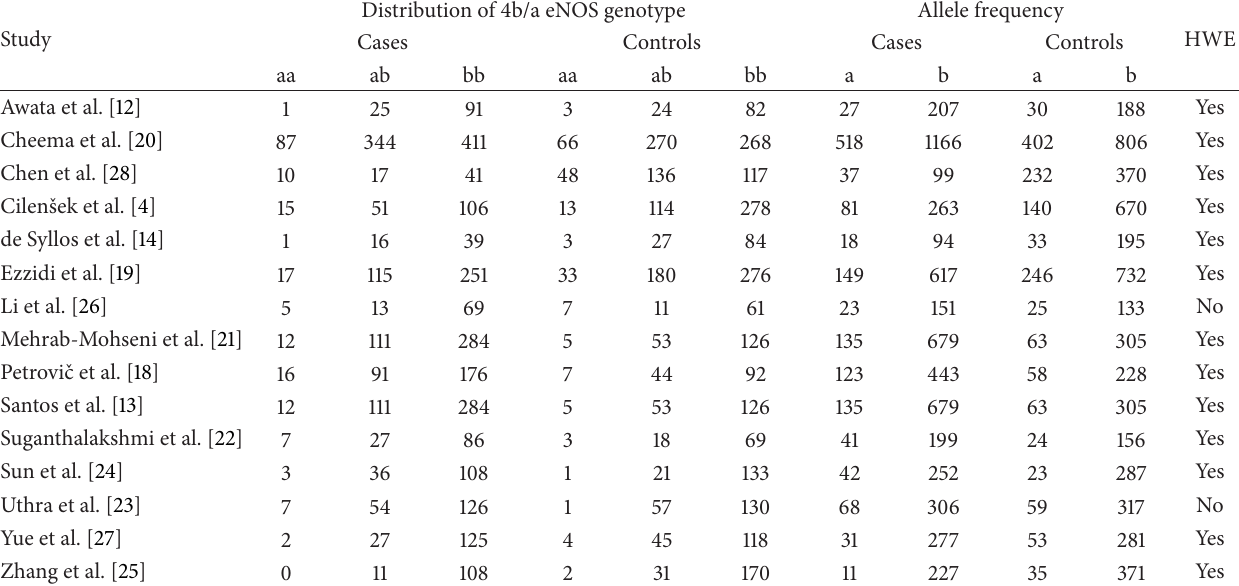
Table 2: The distribution of the 4b/a genotype and allele frequency for cases and